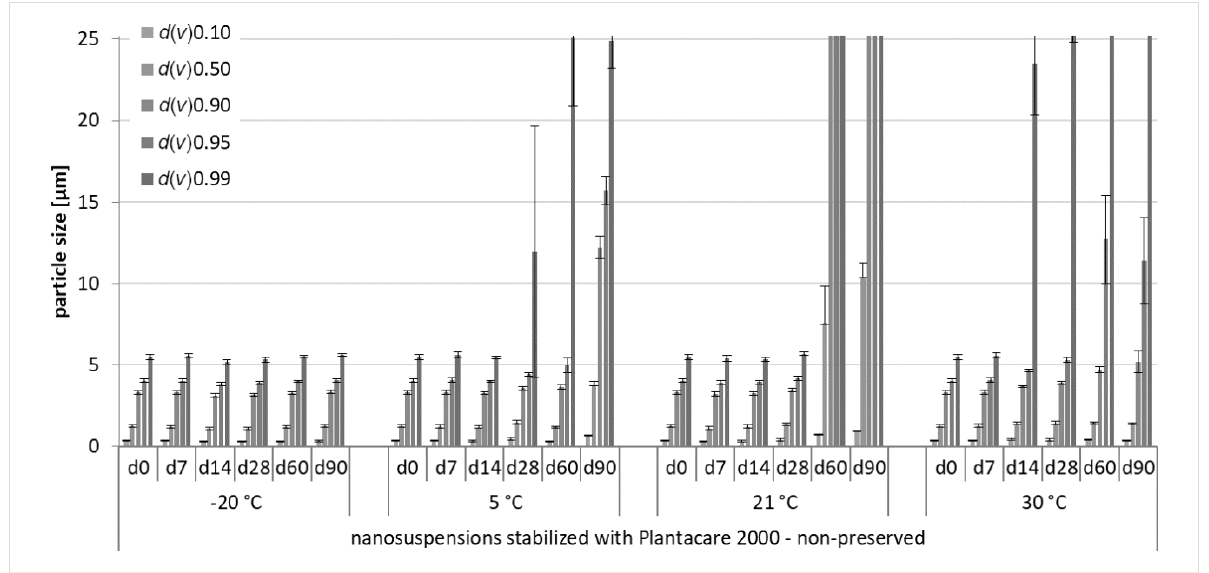
Figure 3: Physical stability during three months of storage at different storage temperatures for the non-preserved nanosuspensions stabilized with Plantacare 2000 (LD data).